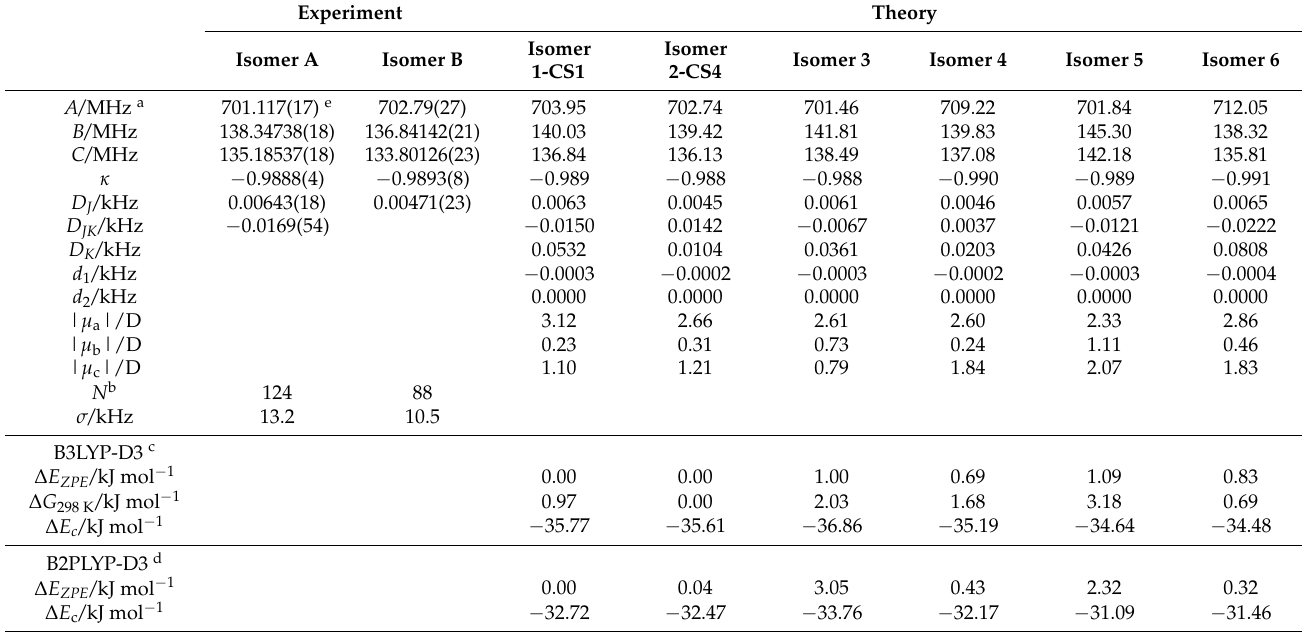
Table 3. Rotational parameters for the 2-adamantanol